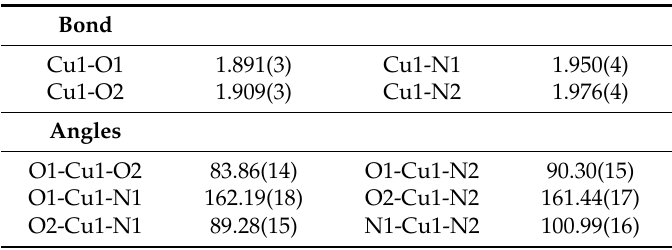
Figure 4. ( a ) X-ray crystal structure and atom numbering of complex 1 with 30% probability displacement ellipsoids; ( b ) Coordination polyhedron of Cu(II) atom of complex 1 . Table 4. Selected bond lengths (Å) and angles (°) for complex 1 .